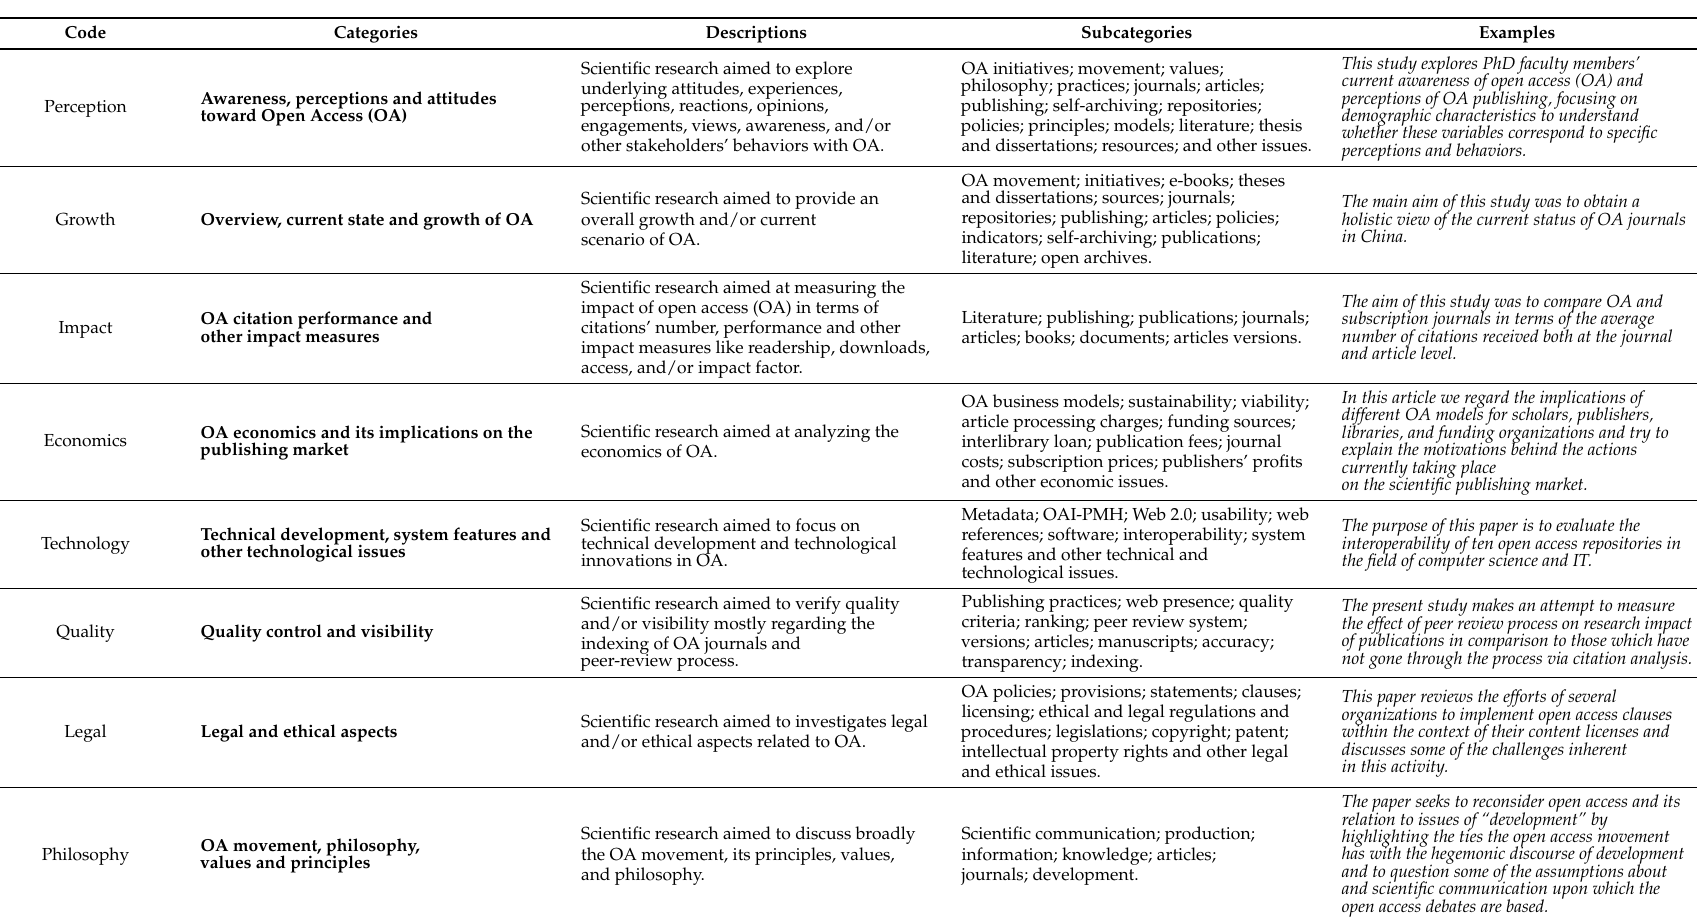
Table 1. Categorization